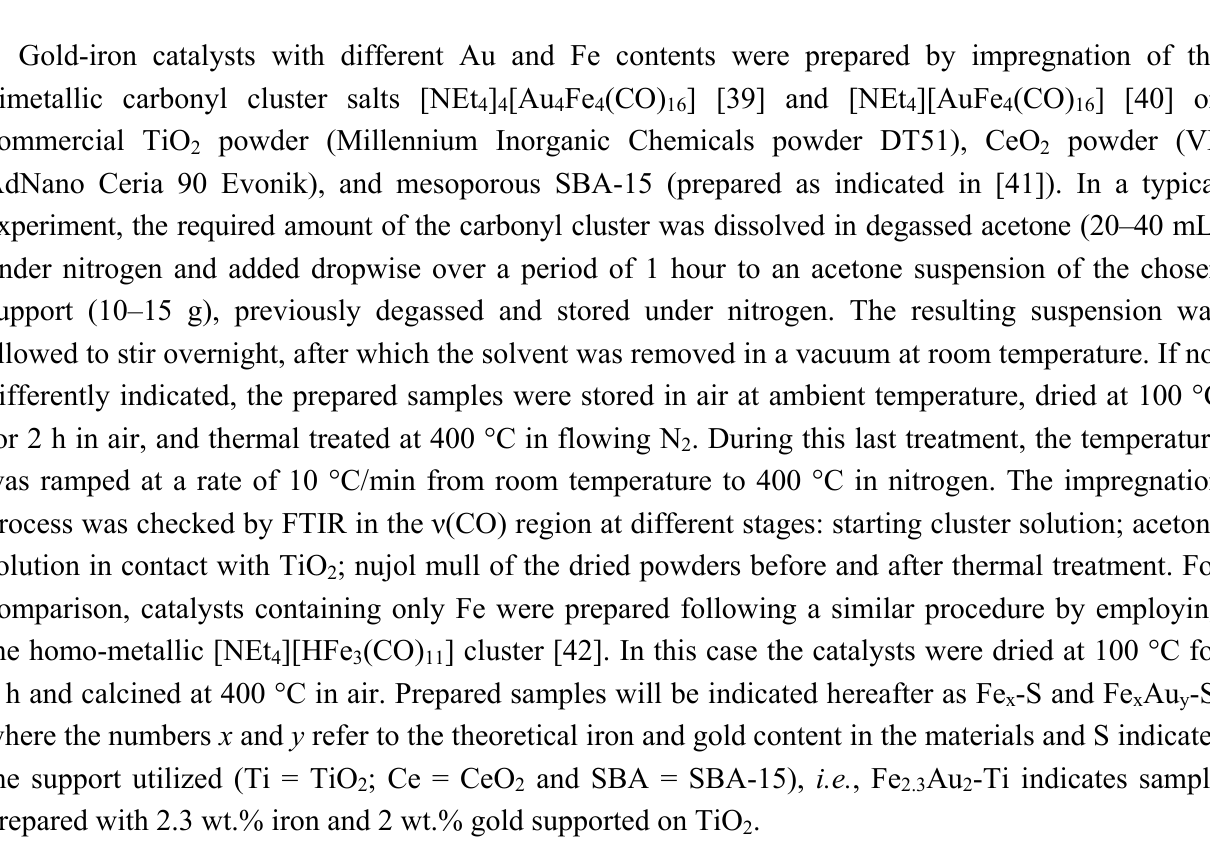
selectivity ( b ) on a Fe 2